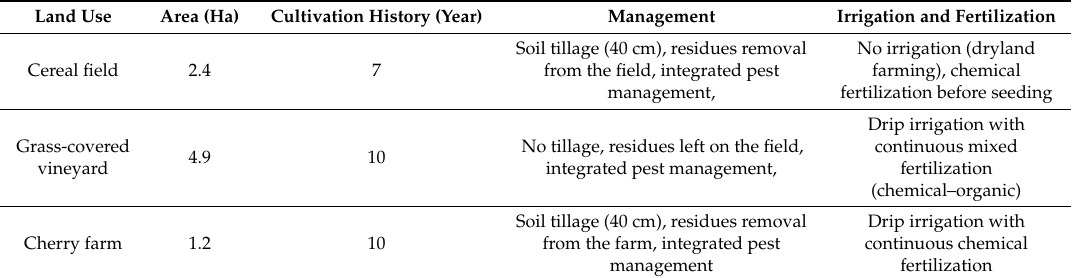
Table 1. Land use